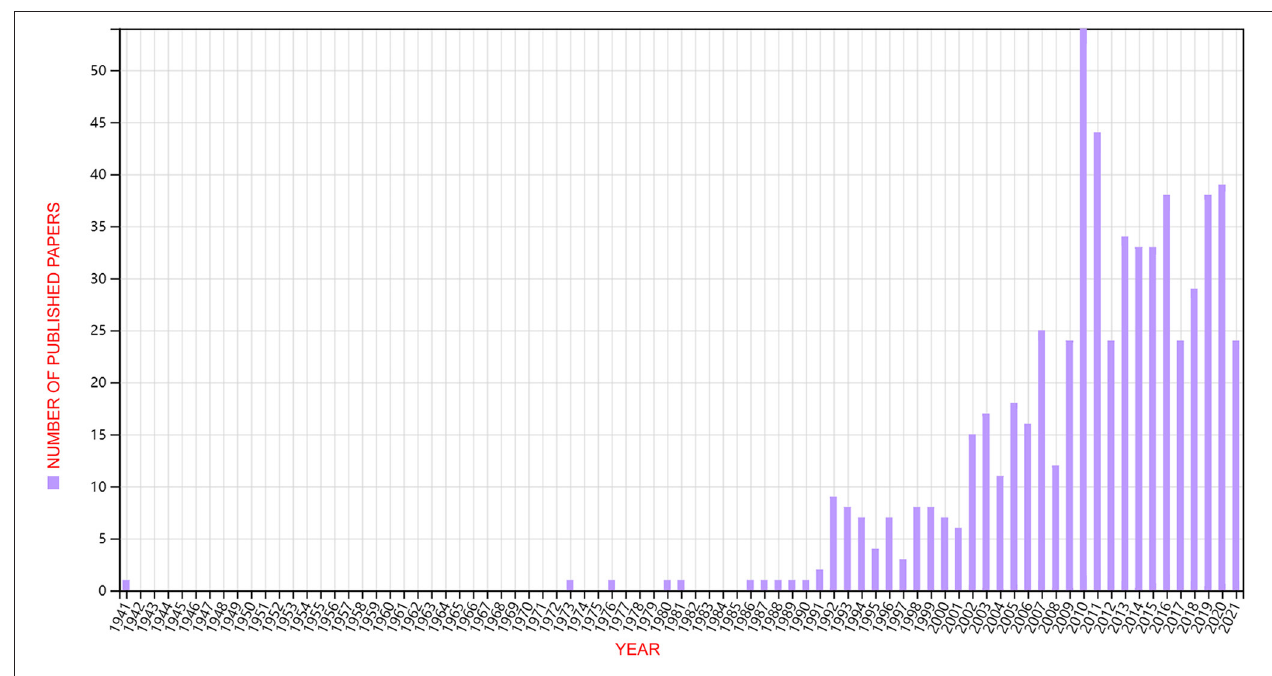
FIGURE 2 | Annual trend chart of publications. The time span was from inception to August 31, 2021.